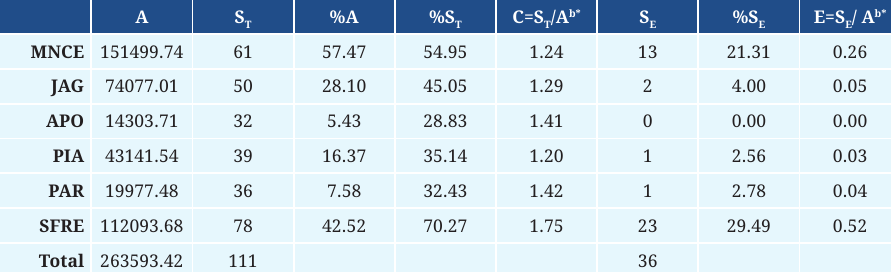
TABLE 3 | Species-area index of the native freshwater fish species in the São Francisco Interbasin Water Transfer Project basins in the Brazilian semiarid. A = Area (km 2 ); S = Total Species; %A = T Proportion of Area; %S = Proportion of Species; C=S /A b = Species Density; S = Endemic Species; T T E %S = Proportion of Endemic species; E=S /A b = Endemic Species Density; SFRE = São Francisco E E Ecoregion (lower-middle São Francisco basin); MNCE = Mid-Northeastern Caatinga Ecoregion (JAG+APO+PIA+PAR); JAG = Jaguaribe basin; APO = Apodi-Mossoró basin; PIA = Piranhas-Açu basin; PAR = Paraíba do Norte basin; b* = the species-area scaling work (0.3264).